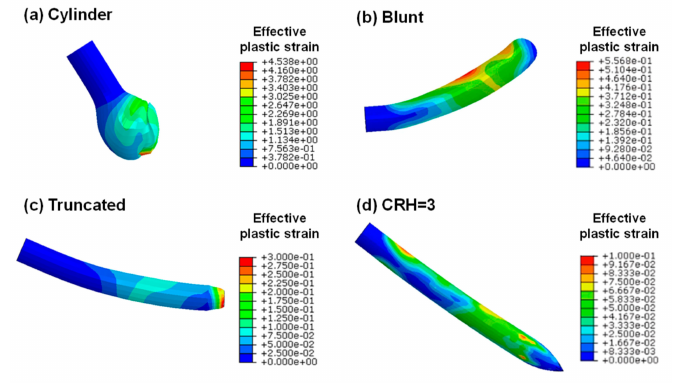
Figure 15. Deformation of the projectile after the oblique penetration; ( a ) Cylinder, ( b ) Blunt, ( c ) Truncated, and ( d ) CRH =